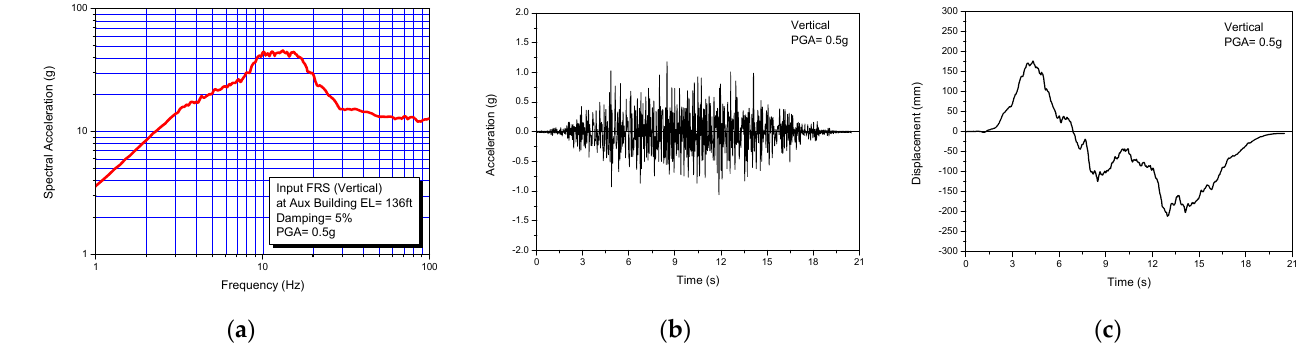
Figure 3. Used vertical seismic input motion (PGA = 0.5 g): ( a ) Floor response spectrum; ( b ) acceleration time history; ( c ) displacement time history.